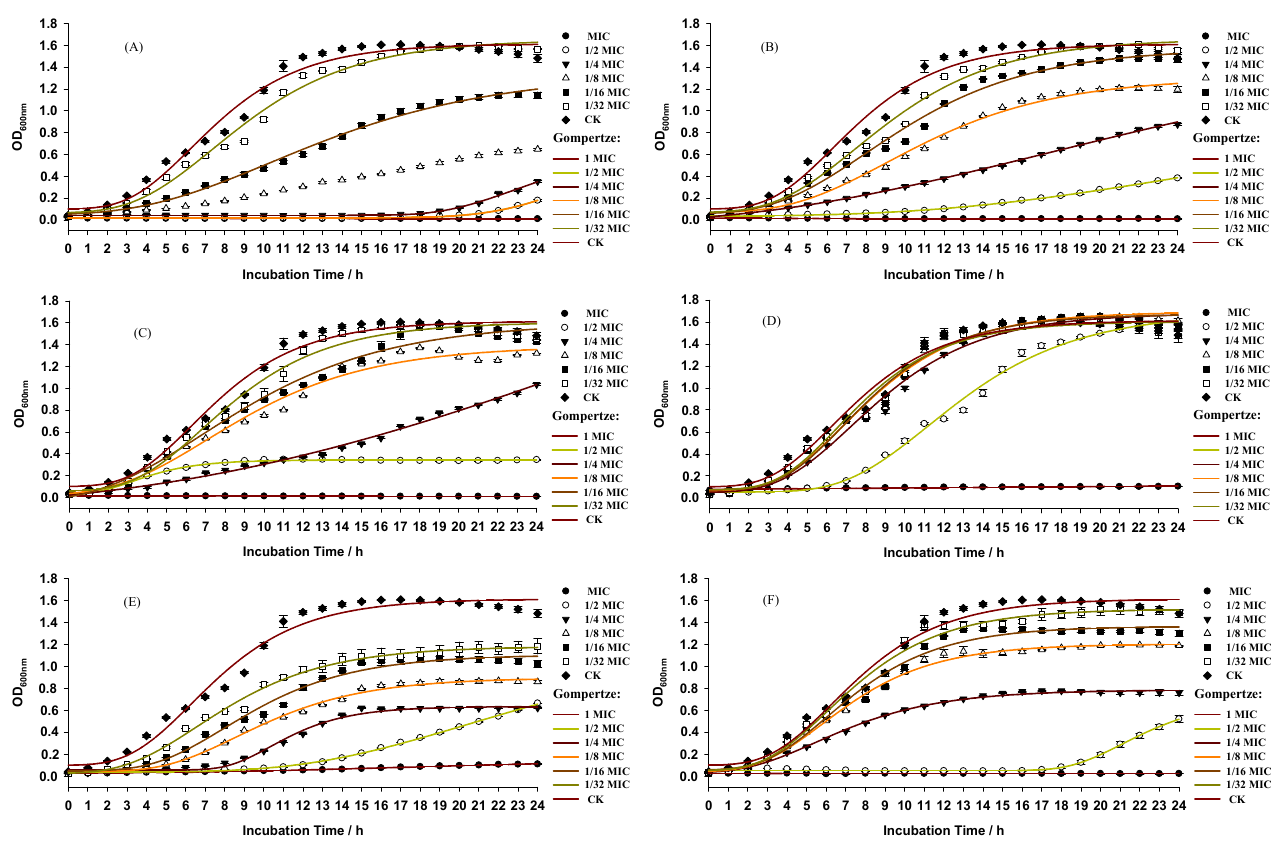
Figure 3. Growth curves for PAO1-CE cultured in LB with various concentrations of Str ( A ), Car ( B ), Amp ( C ), Ter ( D ), Tmp ( E ), or Cip ( F ). Table 2. Kinetic parameters of PAO1-CE during growth in LB with different concentration of Str, Car, Amp, Ter, Tmp, or